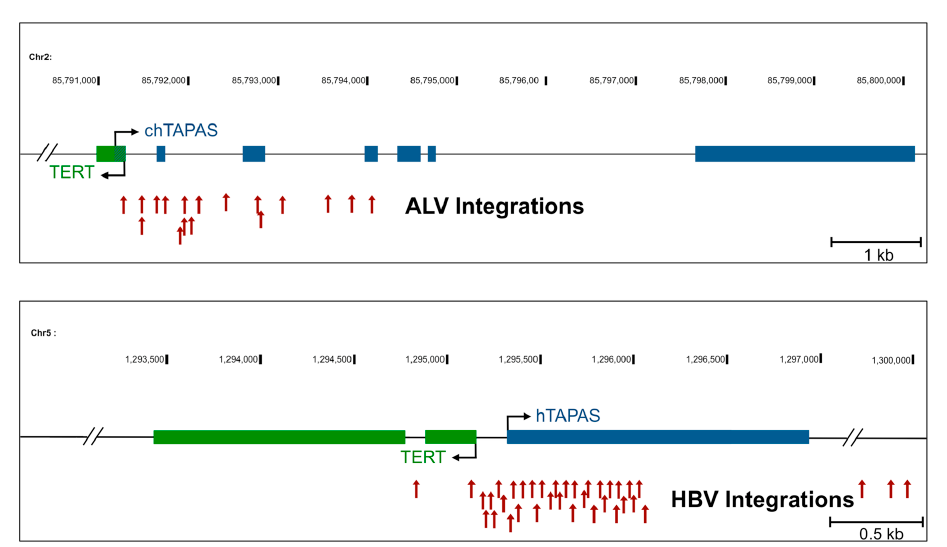
Figure 6. TAPAS is a viral integration hotspot in chicken and human tumors. The schematic represents the hTERT promoter region, including the transcription start sites (black arrows) for hTERT and TAPAS , in the chicken (top) and human (bottom) genomes. This region is depicted as a viral integration hotspot for the avian leukosis virus (ALV) and hepatitis B virus (HBV), respectively in tumors. Red arrowheads represent the integration sites for ALV or HBV in this